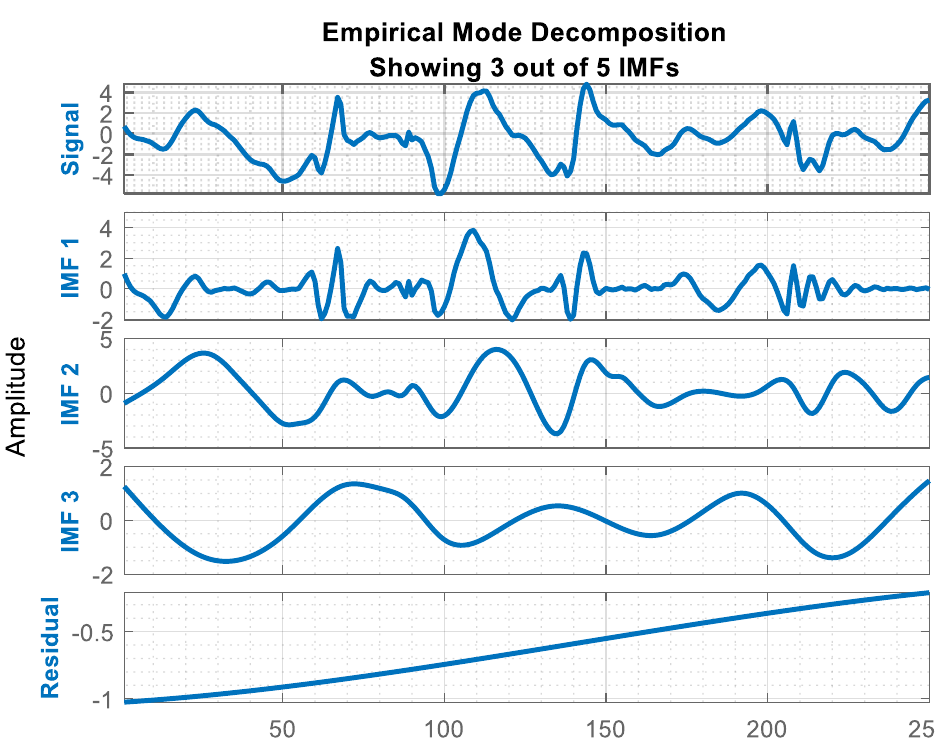
Figure 8. The empirical mode decomposition components from the inertial data.